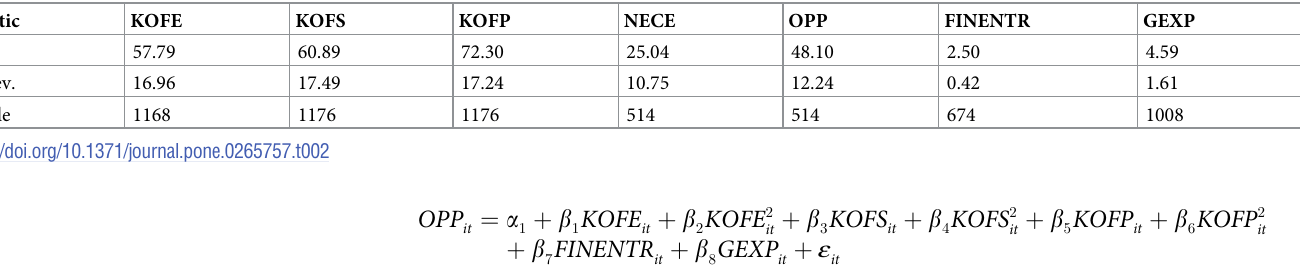
Table 2. Descriptive statistics of variables.